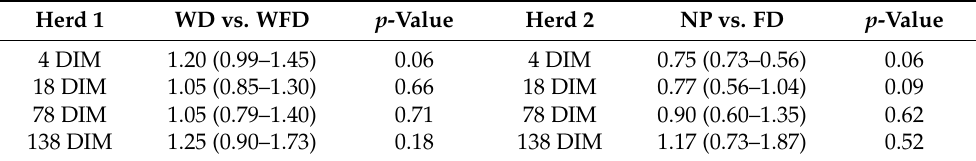
() parenthesis indicates the lower and upper 95% confidence limits.